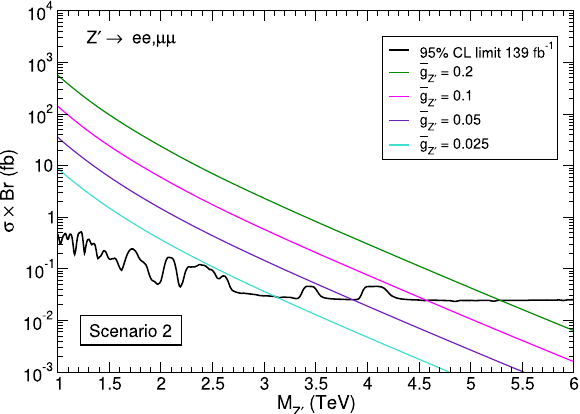
Fig. 2 Limits on Z (cid:2) bosons arising from the search in Ref. [62] in the dilepton final state. Together, we show the cross section predictions for Scenario 2 of Table 3, with ¯ g Z (cid:2) ≡ g Z (cid:2) by definition. For the rest of scenarios the cross sections can be reinterpreted according to (80) and Table